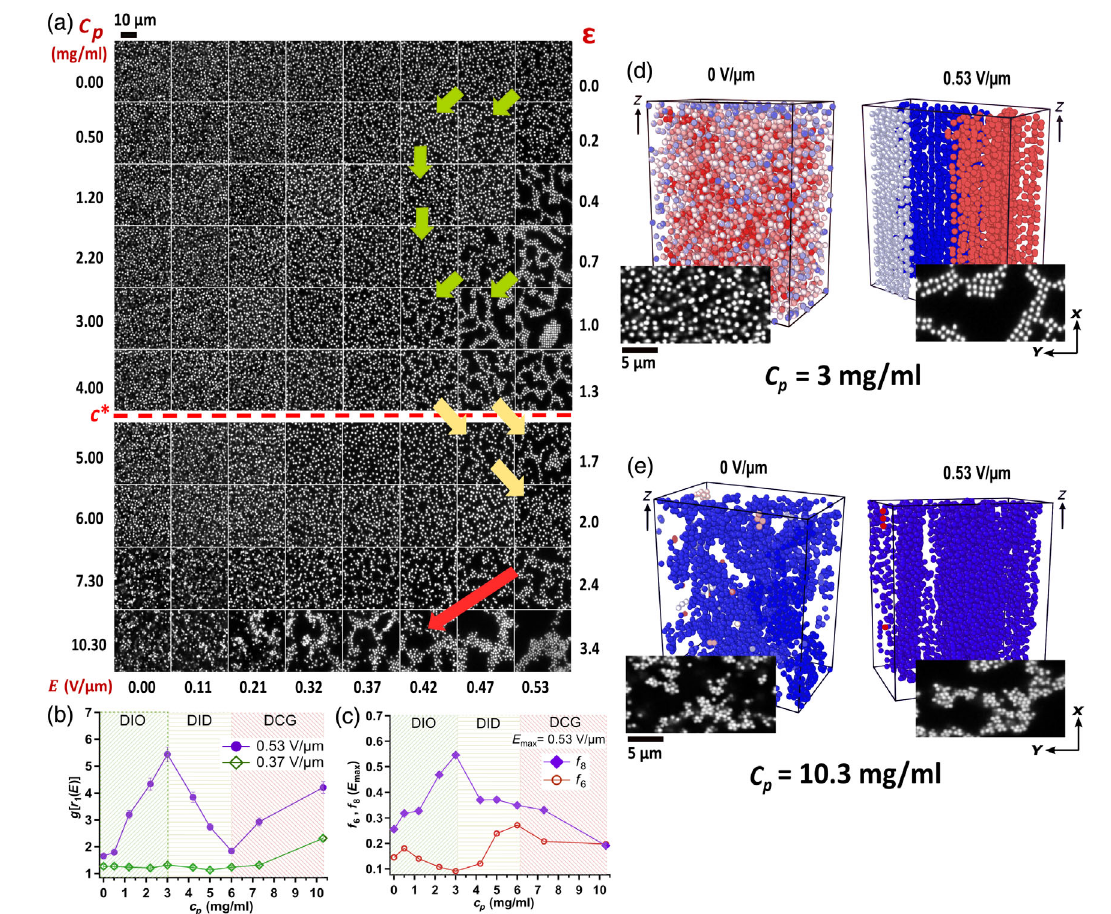
FIG. 2. The dipolar-depletion phase diagram. (a) 2D microscopy images of a colloid-polymer mixture as a function of polymer T is the attractive potential strength corresponding to c concentration c and electric field strength E . ϵ ¼ U 0 =k (see Table I). Each p B p image region of interest shown here is 128 × 128 pixels. c increases from 0 (top row) to 10 . 3 mg = ml (bottom row) and E increases p from 0 V = μ m in the leftmost column to 0 . 53 V = μ m in the rightmost column. Green, yellow, and red arrows qualitatively show the different regimes in the phase diagram and shifts in the field threshold with c for observing ordered and disordered colloidal p ¼ 0 – 3 . 00 mg = ml and c ¼ 7 . 3 – 10 . 3 mg = ml. Yellow arrows: field structures. Green and red arrows: field threshold lowers for c p p ¼ 4 . 00 – 6 . 00 mg = ml. c (cid:3) (red, dashed line) is the overlap polymer concentration. (b),(c) Three different threshold increases for c p ≈ 0 . 53 V = μ m, quantified by displaying g ð r Þ and f regimes in the dipolar-depletion phase diagram at E 1 8 , f 6 as a function of c p . max The 3 regimes are demarcated by different colors in the graph. DIO (green): depletion induced ordering; DID (yellow): depletion induced disordering; DCG (red): dipolar chain gel. (d) 3D views ð 20 . 24 × 34 . 64 × 40 . 63 μ m 3 Þ (generated using OVITO [57]) and ¼ 3 mg = ml for no-field ( 0 V = μ m, left) and maximum field strength (inset) 2D confocal microscope images of the suspension, at c p ¼ 10 . 3 mg = ml for 0 V = μ m ( 0 . 53 V = μ m, right) respectively. (e) 3D view and 2D confocal images of a single spanning cluster at c p (left) and 0 . 53 V = μ m